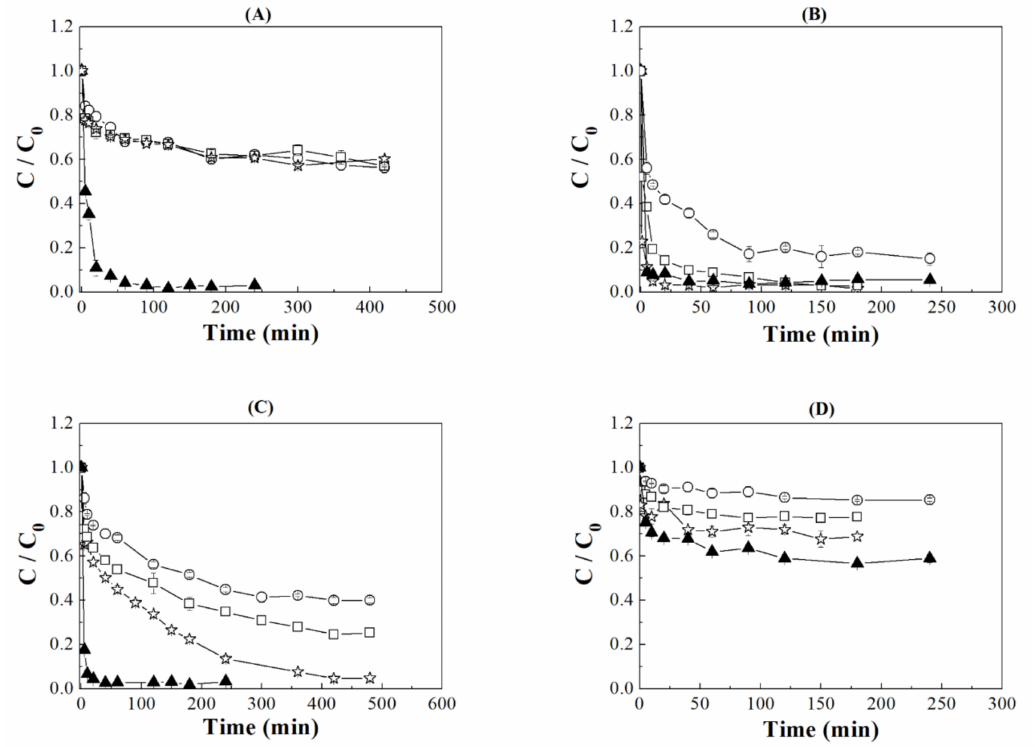
Figure 3. Kinetic profiles of IgG adsorption ( A , C ) and HSA (B,D) in: Si ( (cid:78) ), SiZr20 (*), SiZr10 ( (cid:3) ) and SiZr5 ( ( A , B ) buffer at pH 4,8 and phosphate ( C , D ) at pH 7.0. : the error of each